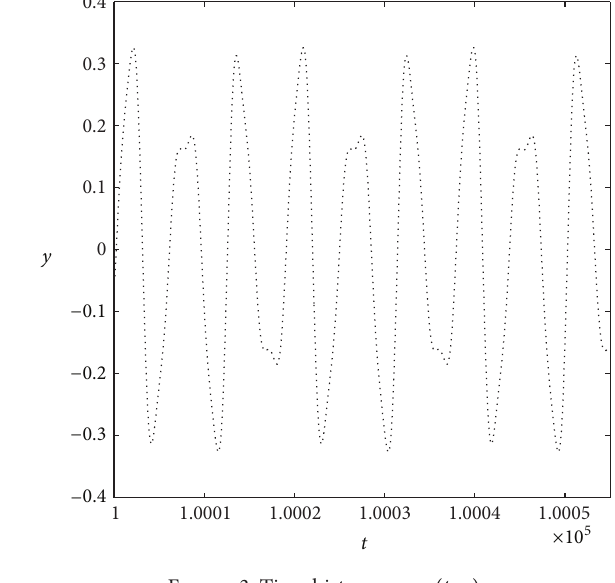
Figure 3: Time history curve (𝑡,𝑦) .